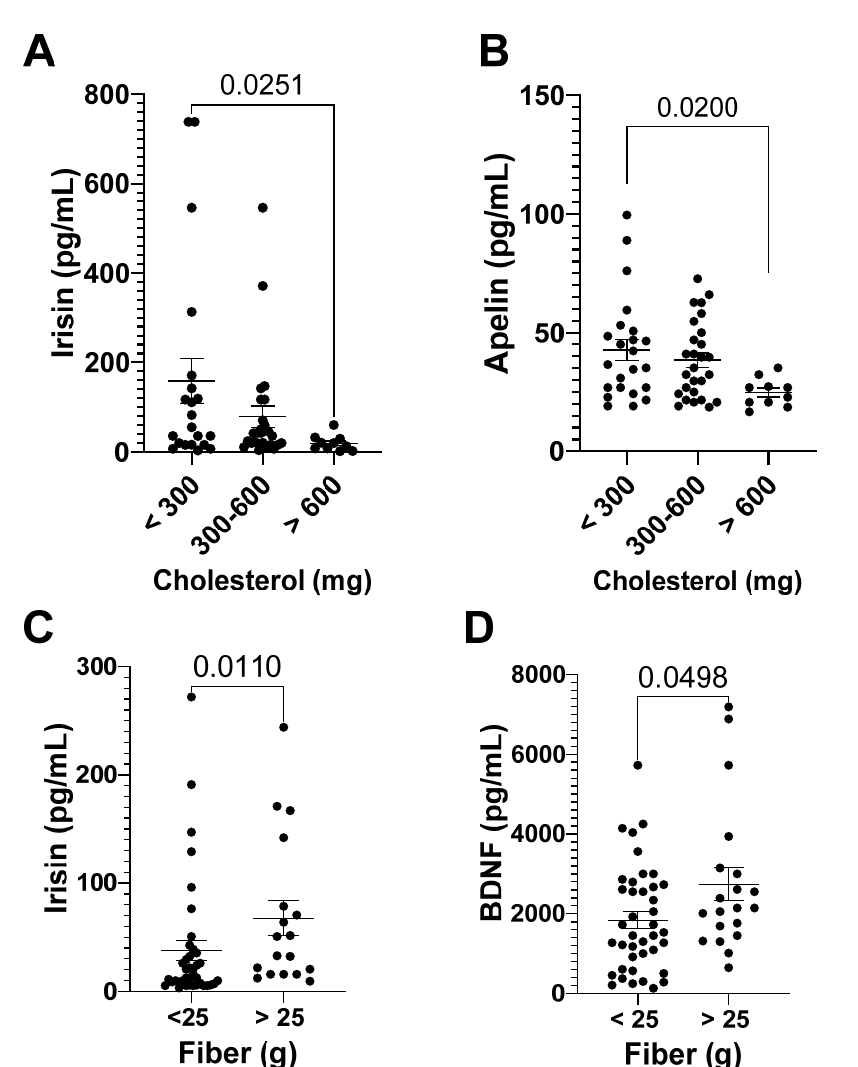
Figure 4. Myokine levels and cholesterol and fiber intake. Irisin ( A ) and apelin ( B ) levels after the race, and irisin ( C ) and BDNF ( D ) levels 72 h after the race. The myokine levels are presented as mean ± EPM, as well as individuals’ values.